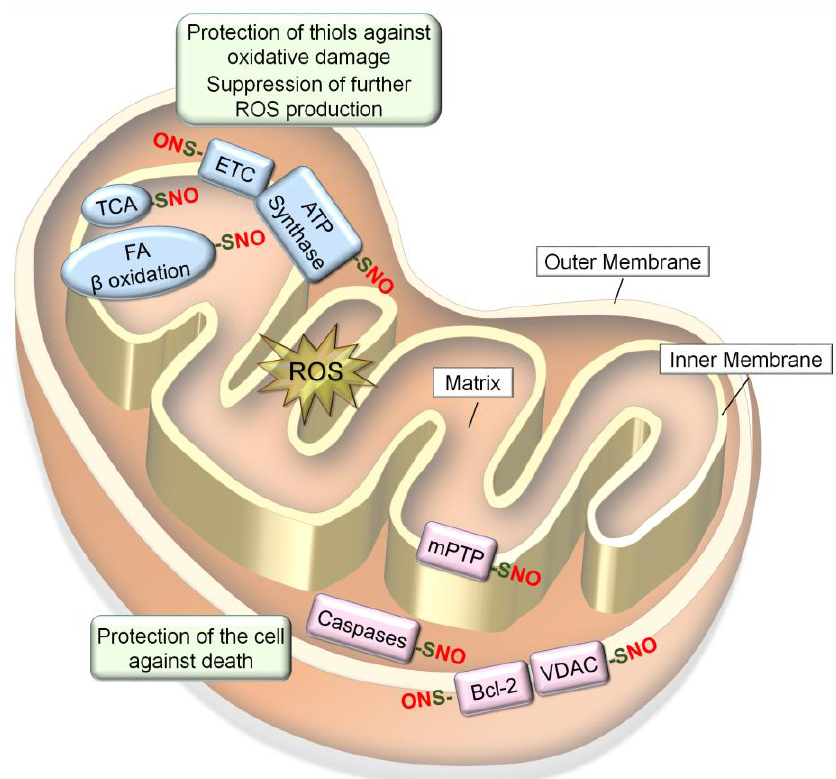
Figure 4. S-nitrosylation of mitochondrial proteins confer resistance to oxidative stress. Mitochondrial proteins become S-nitrosylated in oxidizing environments. S-nitrosylation of proteins involved in respiration and energy production (Electron Transport Chain (ETC), adenosine triphosphate (ATP) synthesis, the citric acid (TCA) cycle and fatty acid β oxidation) leads to prevention of ROS production and protection of protein thiols in these enzymes against oxidative damage. In contrast, S-nitrosylation of proteins involved in cell death regulation (mPTP, caspases-3 / -9, VDAC and Bcl-2) leads to protection of the cell against death signals.